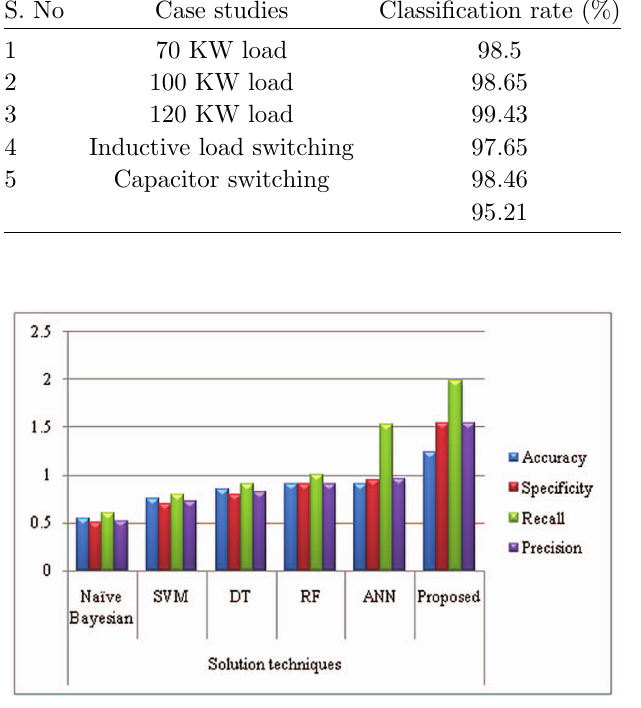
Fig. 17. Performance comparison of proposed using existing system for 50 trials.